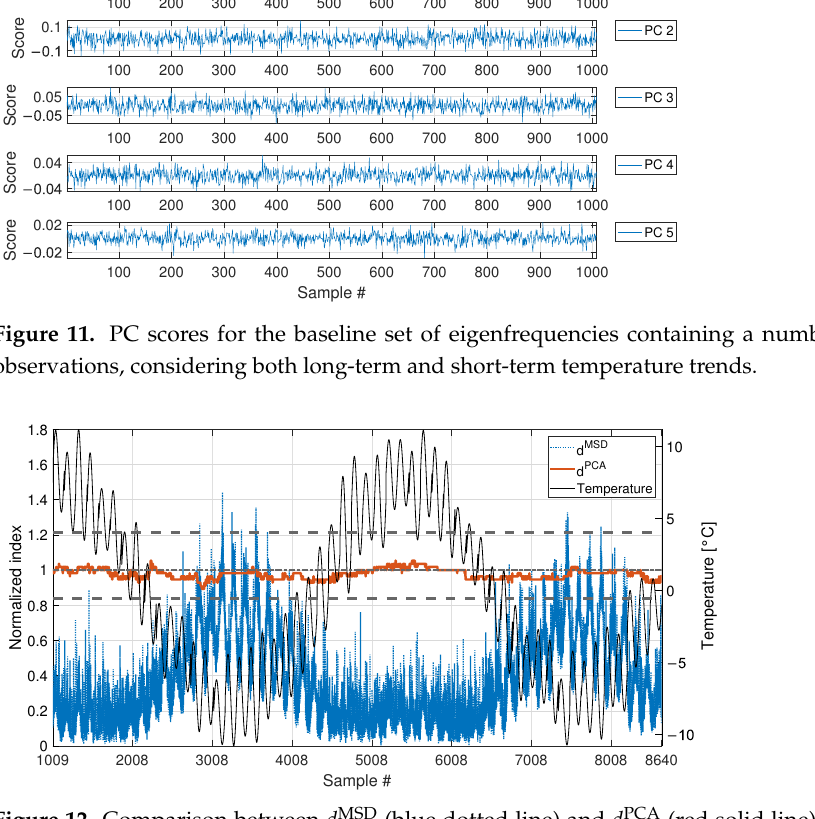
Figure 12. Comparison between d MSD (blue dotted line) and d PCA (red solid line), with b = 1008, considering both long-term and short-term temperature trends (black thin